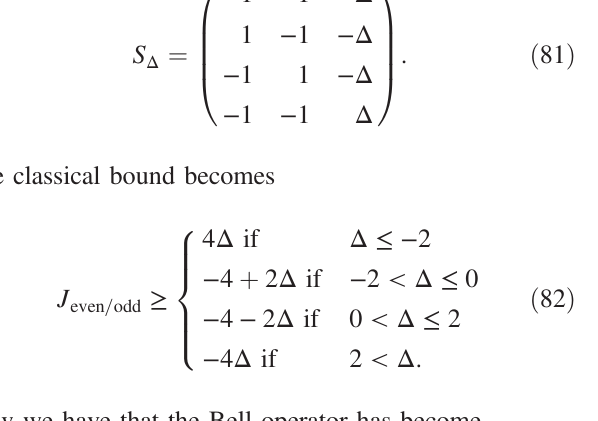
β . The C ¼ Q < β ). Note that in the bottom C Q = β < 1 due to the fact Q C and σ (the = 4 y and σ as = 4 y